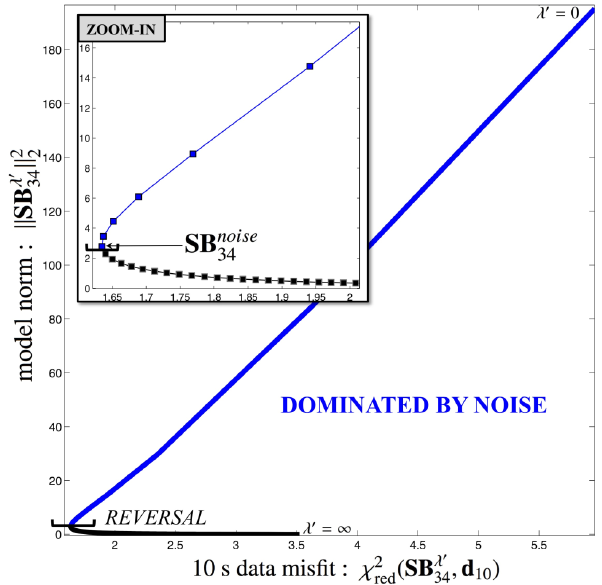
Fig. 3. Illustration of the coherency analysis. It consists in testing 0 how well single-band models, SB λ (inversion of 34s data), fit the 34 10s data ( d 10 ) as damping λ 0 varies. The curve of trade-off be- 0 || 2 , and its 10s data mis- tween the single-band model norm, || SB λ 34 2 0 ( SB λ , d 10 ) , is characterised by a “reversal” which occurs fit, χ 2 red 34 for damping λ 0 . Single-band models with damping λ 0 ≤ λ 0 noise noise are identified as “dominated by